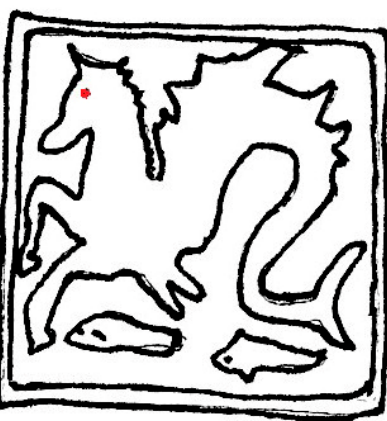
Figure 10. Horse-fish creature (hippocamp) in a mosaic panel; drawing of a scene from the House of the Mosaics; ca. 6th–5th century BCE .